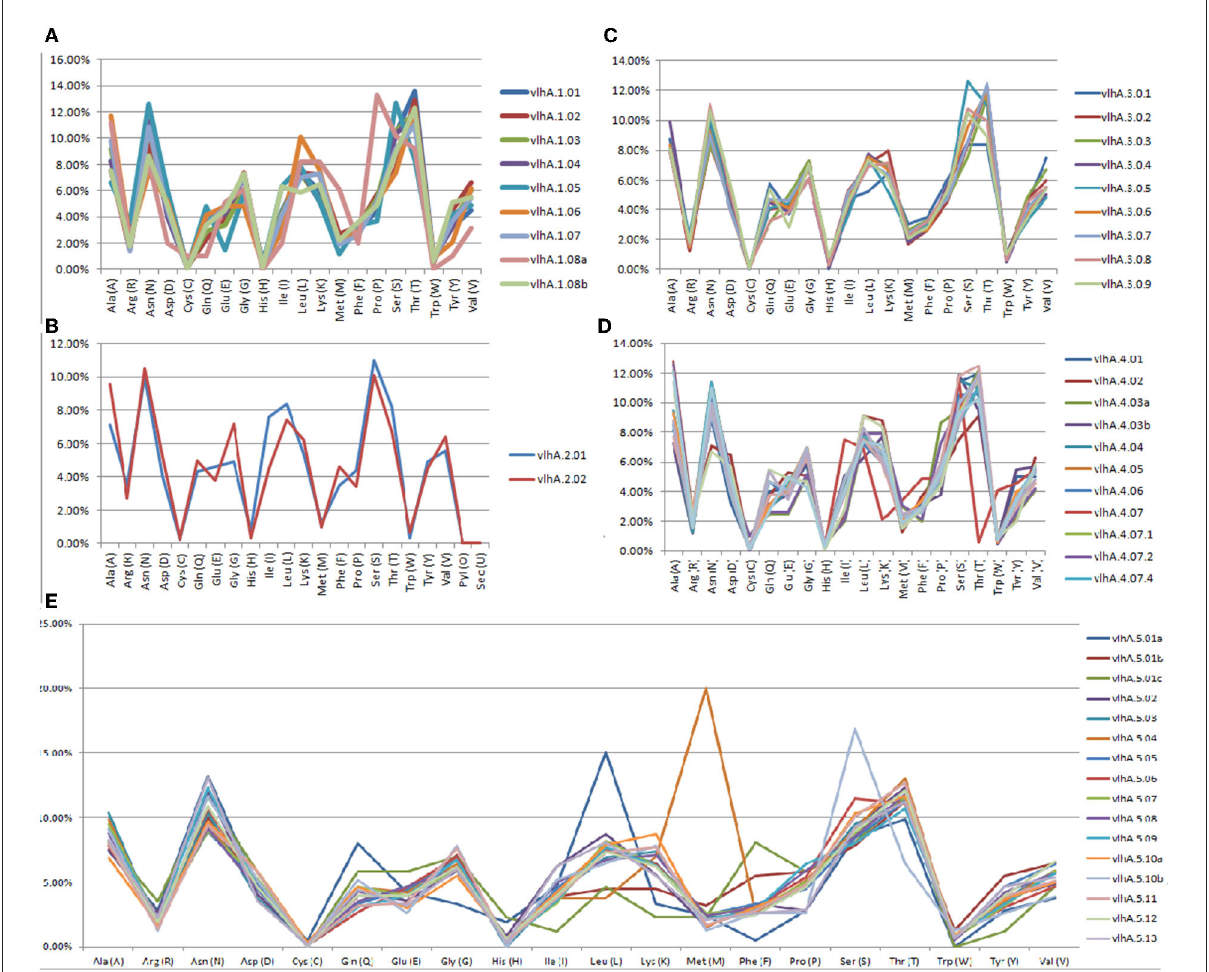
FIGURE3 Graphical representation of amino acid composition of M. gallisepticum vlhA proteins. (A) vlhA 1 group, (B) vlhA 2 group, (C) vlhA 3 group, (D) vlhA 4 group, and (E) vlhA group